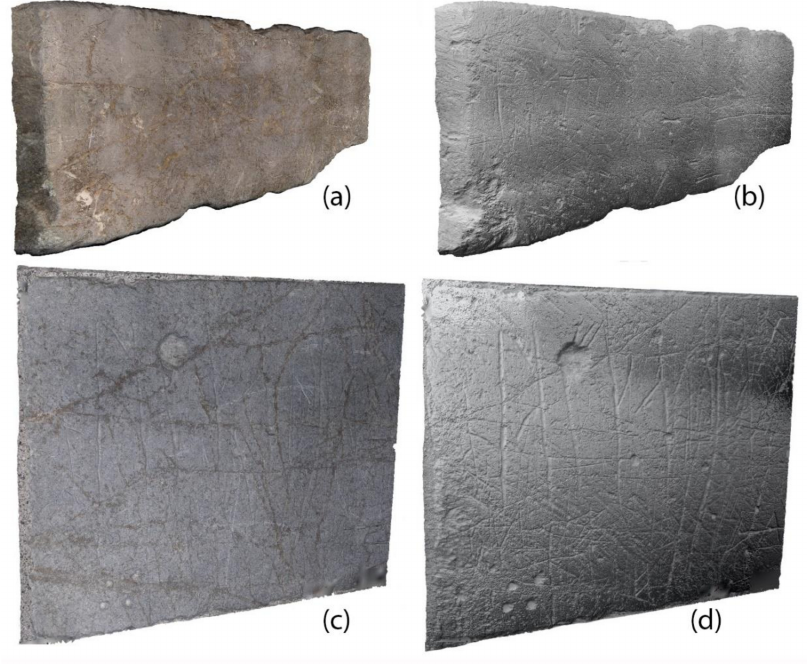
Figure 8. The recorded surfaces with IBM generated photographic texture maps (left) and RTI generated surface texture maps (right); ( a ) Surface A, Combo 2MS; ( b ) Surface A, Combo 2MS; ( c ) Surface B, Combo 2RC; and ( d ) Surface B, Combo 2RC. The surface texture maps in images b) and d) are based only on lights and shadows from the RTI processing and show great levels of details obscured in the photographic texture maps in images ( a ) and ( c ). All images are available in full resolution